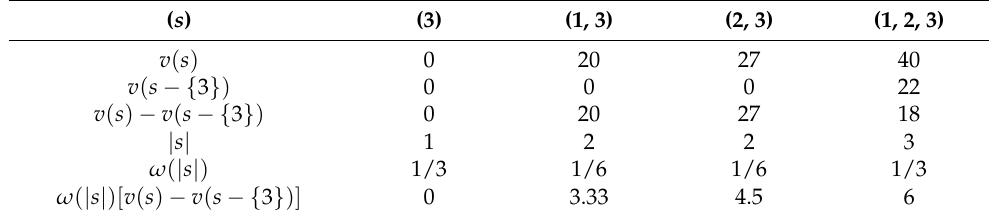
Table 3. Profit distribution table of enterprise